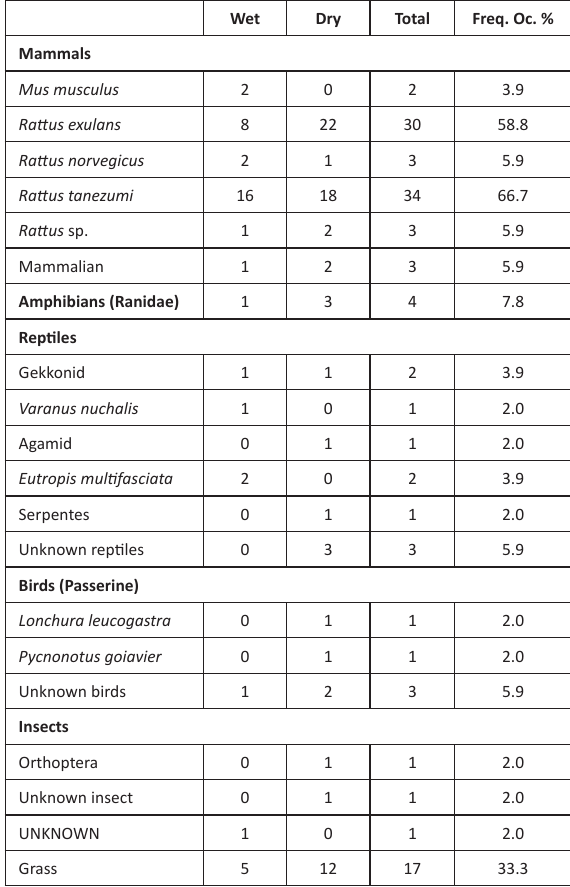
Table 5. Taxonomic composition of prey according to climatic seasons